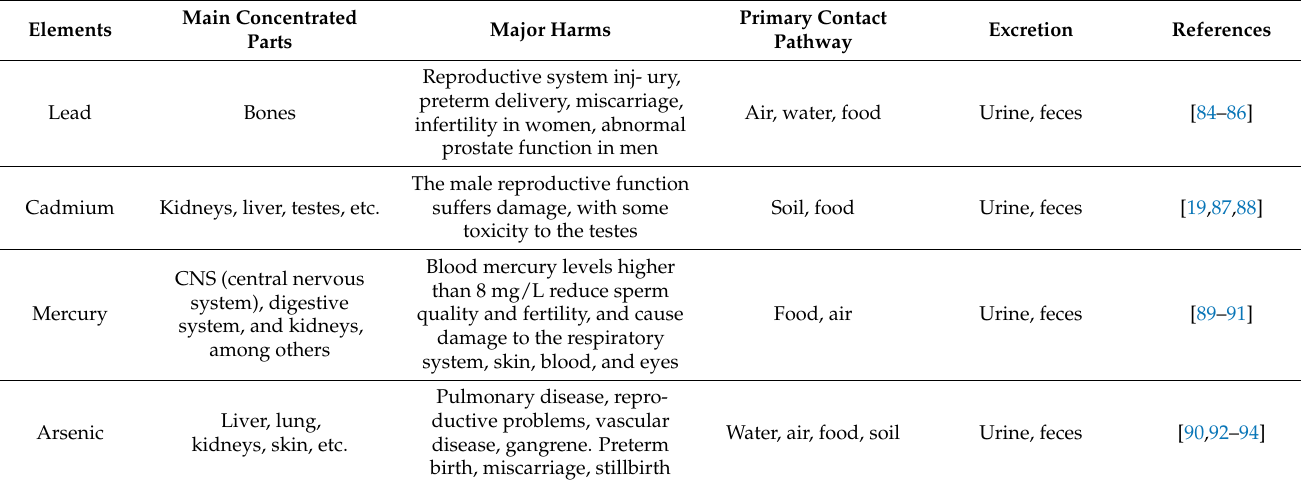
Table 6. Functional characteristics of four heavy